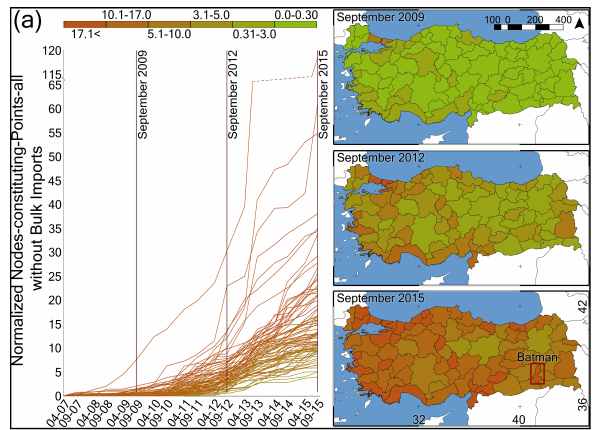
Figure 2. Point nodes density evolution with time. The y-axis (also represented with colour legends) is the number of nodes constituting Points(all) without bulk imports per km 2 area (nor- malized by dividing with